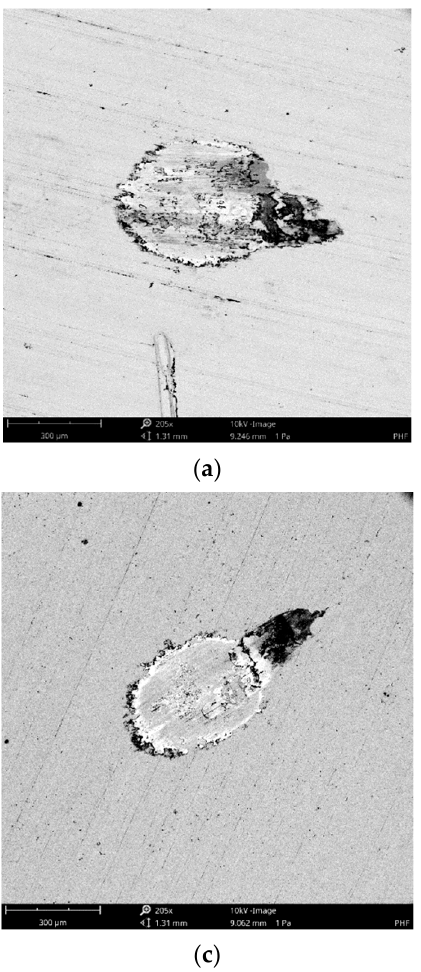
Figure 10. The SEM views of the milled disc surface after tribological tests for the normal load of 20 N ( a ), 40 N ( b ), of burnished disc surface with pressure of 10 MPa for the normal load of 20 N ( c ) and of burnished disc surface with a pressure of 30 MPa for the normal load of 40 N ( d ).